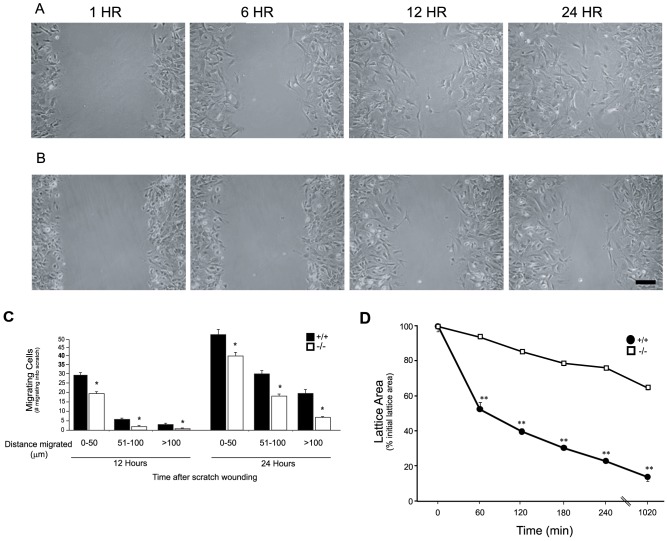
Reduced cellular motility and contractility in Acta2 deficient cells.
Acta2 wild type (+/+) and null (−/−) fibroblasts were isolated from mouse embryos as in Methods. At the second to sixth passage, cells were plated in monolayers at uniform density and subjected to scratch wounding as in Methods. In (A) (+/+) and (B) (−/−), representative examples of cells migrating into scratched areas at different times are shown. In (C), cells migrating the specified distances and 12 and 24 hours after scratch wounding were counted (n = 6, *p<0.01 for +/+ vs. −/− cells). In (D), stellate cells from Acta2 deficient (−/−) and wild type (+/+) were placed on top of collagen lattices and contraction was measured as in Methods (n = 4, **p<0.005 for +/+ vs. −/− cells).